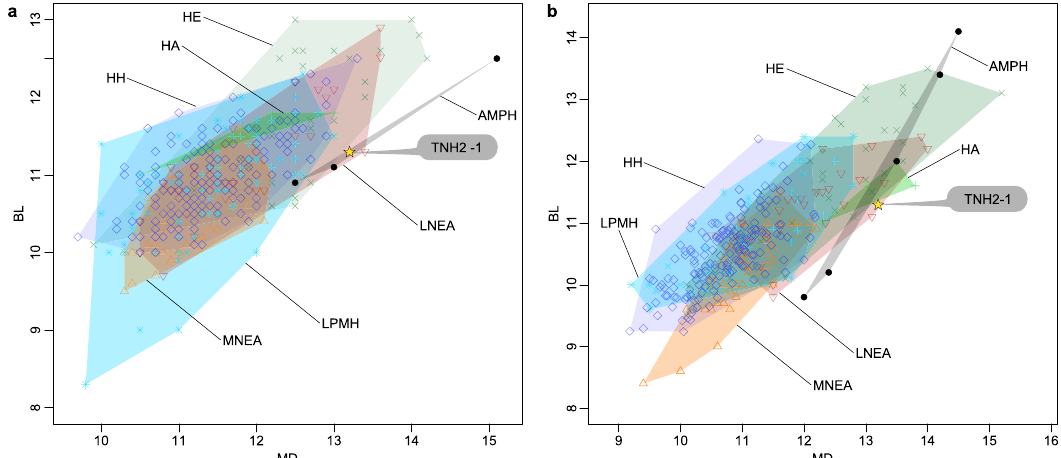
Fig. 4 Metrical features of the TNH2-1 specimen. Bivariate scatter plots of the mesiodistal and buccolingual crown dimensions of TNH2-1 compared with the M1s ( a ) and M2s ( b ) of H. erectus (HE; green crosses), H. antecessor (HA; green pluses), Middle Pleistocene Neanderthals (MNEA; orange triangles), Late Pleistocene Neanderthals (LNEA; red inverted triangles), Asian Middle Pleistocene Homo (AMPH; dark dots), Late Pleistocene modern humans (LPMH; blue asteriks) and Holocene humans (HH; blue diamonds). Source data are provided as a Source Data fi